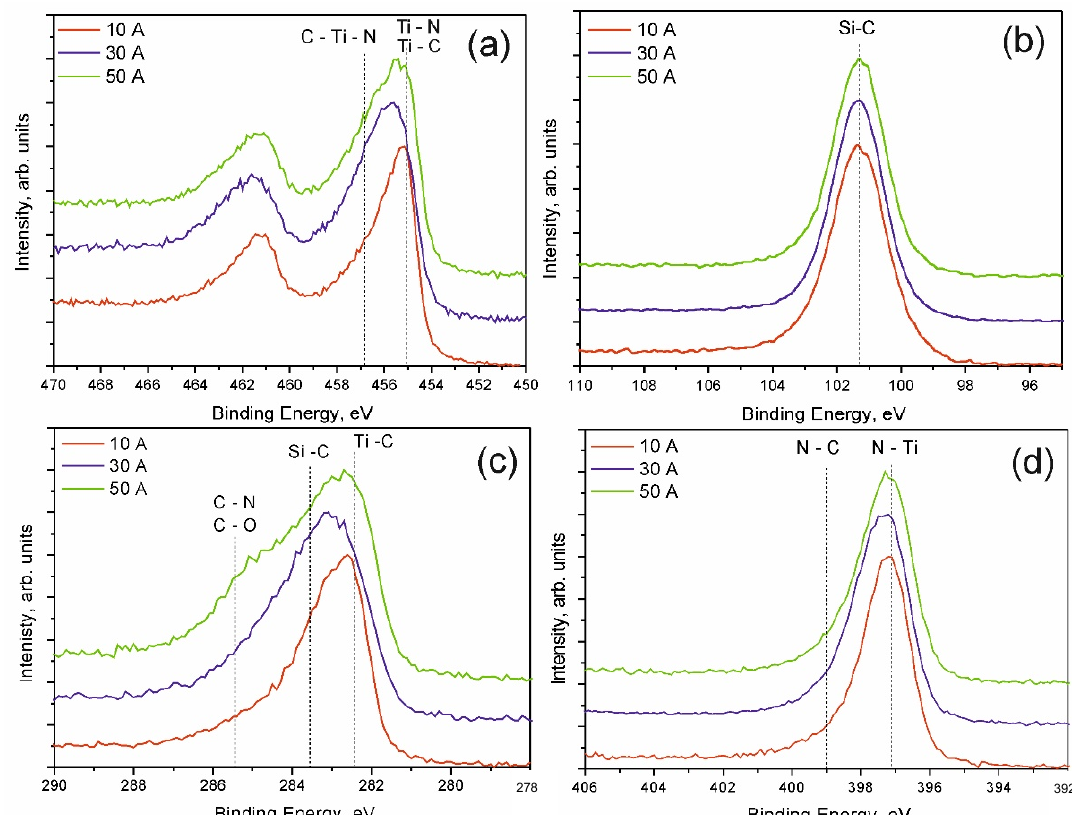
Figure 6. XPS spectra of TiSiCN coatings. Ti2p ( a ); Si2p ( b ); C1s ( c ); N1s ( d ).